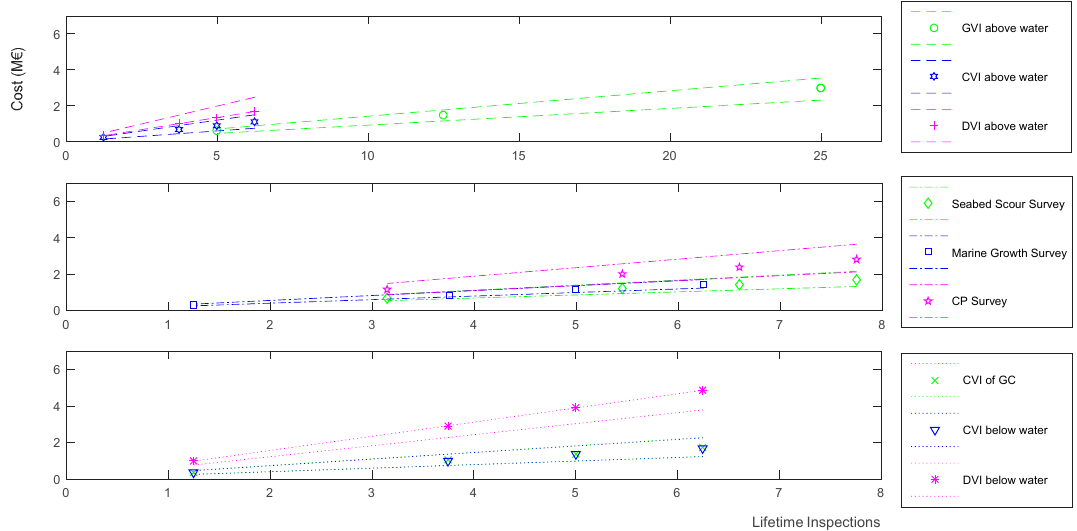
Figure 7. Lifetime cost of inspection depending on the lifetime inspection frequency.